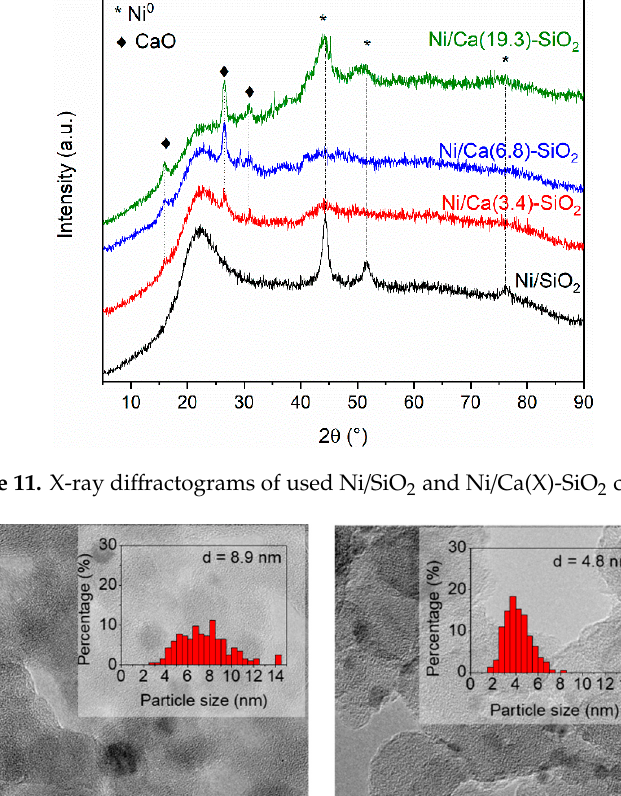
Figure 12. TEM images of used samples: ( a ) Ni/SiO 2 and ( b ) Ni/Ca(19.3)-SiO 2 ; the histograms were included.